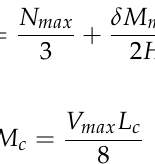
Figure 30 indicates the relative value of internal force. The maximum value is set to 1.